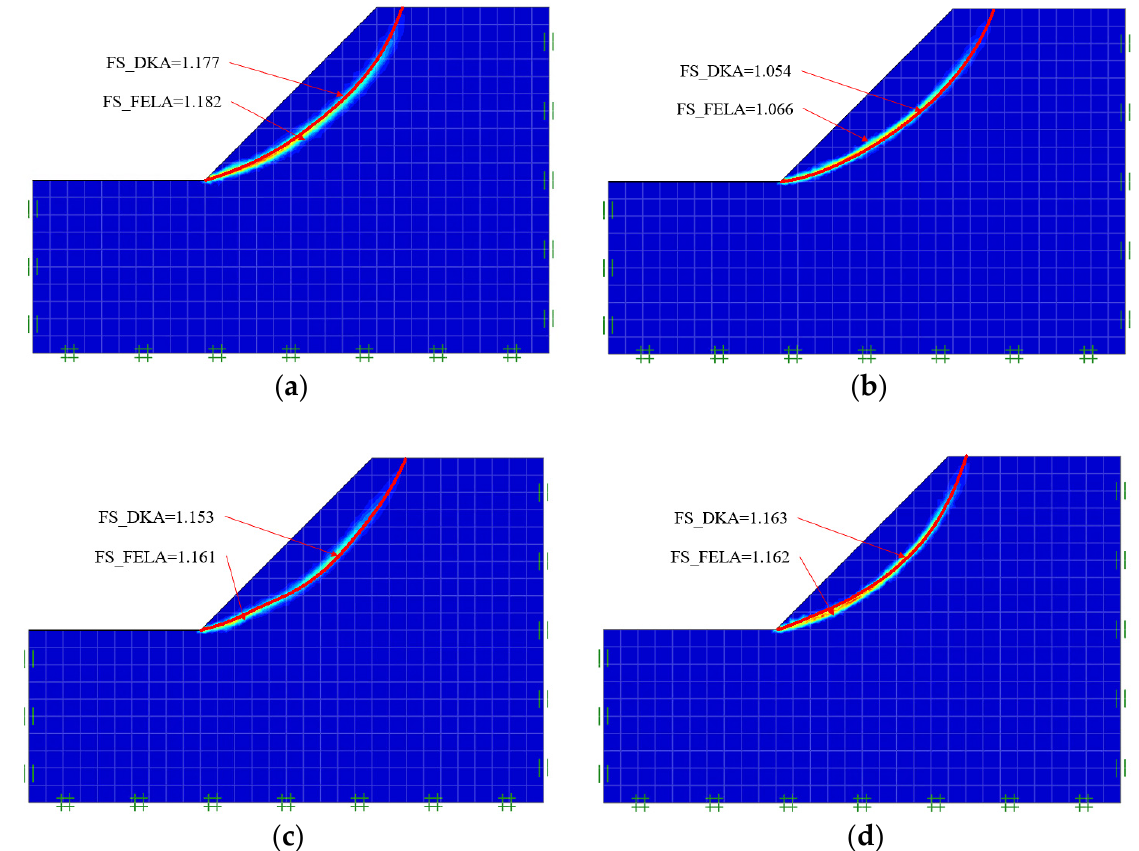
Figure 9. Comparison of deterministic models with different values of random field rotation angle. ( a ) β = 0°; ( b ) β = 45°; ( c ) β = 90°; ( d ) β = 135°.